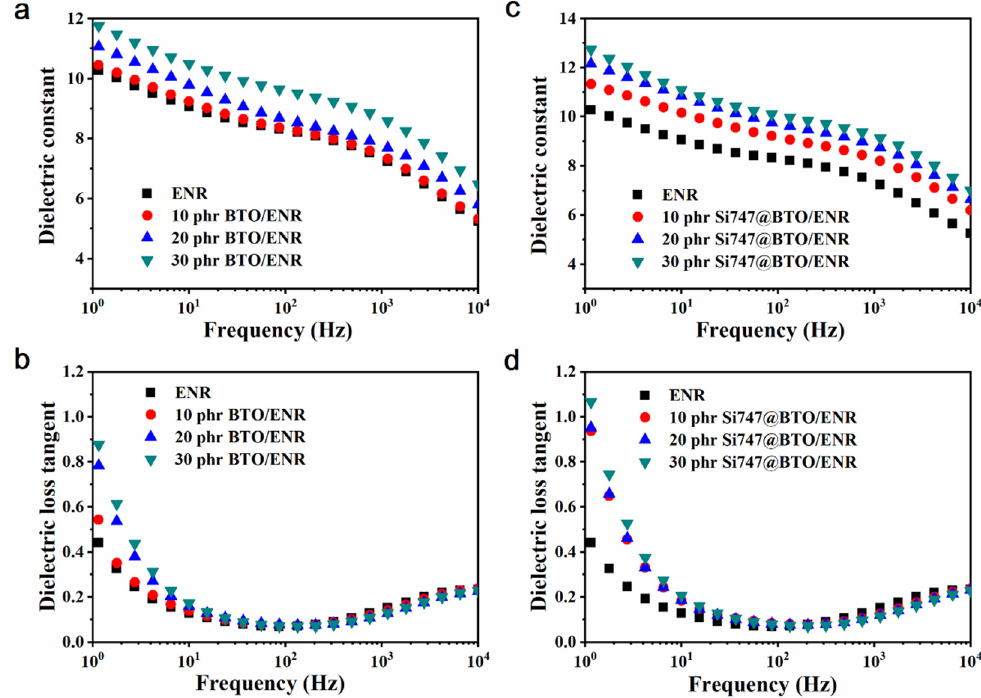
Figure 5. Frequency dependencies of ε r ( a , c ) and tan δ ( b , d ) in the ENR composites. The changes in actuated strains of ENR composites with various loadings of BTO and Si747@BTO nanoparticles, as a function of the electric field, are displayed in Figure 6a,b, re- spectively. Under a certain electric field, BTO/ENR and Si747@BTO/ENR composites both showed the largest electrically actuated strains in the 10 phr filler. This can be interpreted by the lowest Y and increased ε r leading to the largest β (Figure 6c). In regard to nanoparticles from 20 phr and 30 phr, the actuated strains of ENR composites declined. However, the Si747@BTO/ENR composites displayed larger actuated strains than BTO/ENR composites at the same filler loading and electrical field. For example, the 10 phr BTO/ENR composite displayed an actuated strain of 6.27% at 40 kV/mm, while the 10 phr Si747@BTO/ENR composite showed an actuated strain of 8.34% within the same electric field. The improved actuated strains resulted from the larger β of Si747@BTO/ENR composites. The dielectric strength of ENR composites also decreased with the increase in the filler amount. The gaps induced by the inorganic fillers and in the intervention of air, with a breakdown strength around 3 V/mm, led to reduced dielectric strength. After modification by Si747, the electric field intensity at the interface between dielectric nanoparticles and the ENR matrix became homogeneous, resulting in Si747@BTO/ENR composites with higher dielectric strengths than those of BTO/ENR composites [41,42].